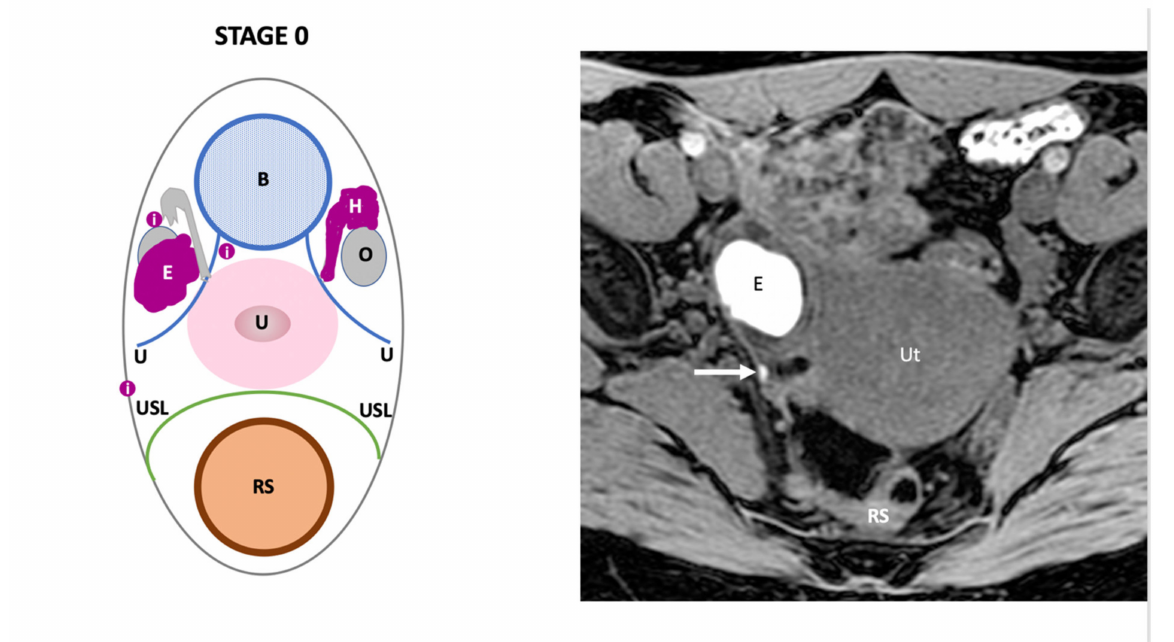
Figure 1. Schematic and example of stage 0 Endo-Stage MRI classification showing the presence of an endometrial cyst ( E ) that displays high signal intensity on a T1-weighted MR with fat-saturation associated with a superficial peritoneal implant ( i ), arrow. Note: ( B ): bladder, ( RS ): rectosigmoid colon, ( O ): ovary, ( U ): ureter, ( H ): hematosalpinx, ( Ut ): uterus, red point: uterine artery at crossing level. ( USL ): Uterosacral ligament.